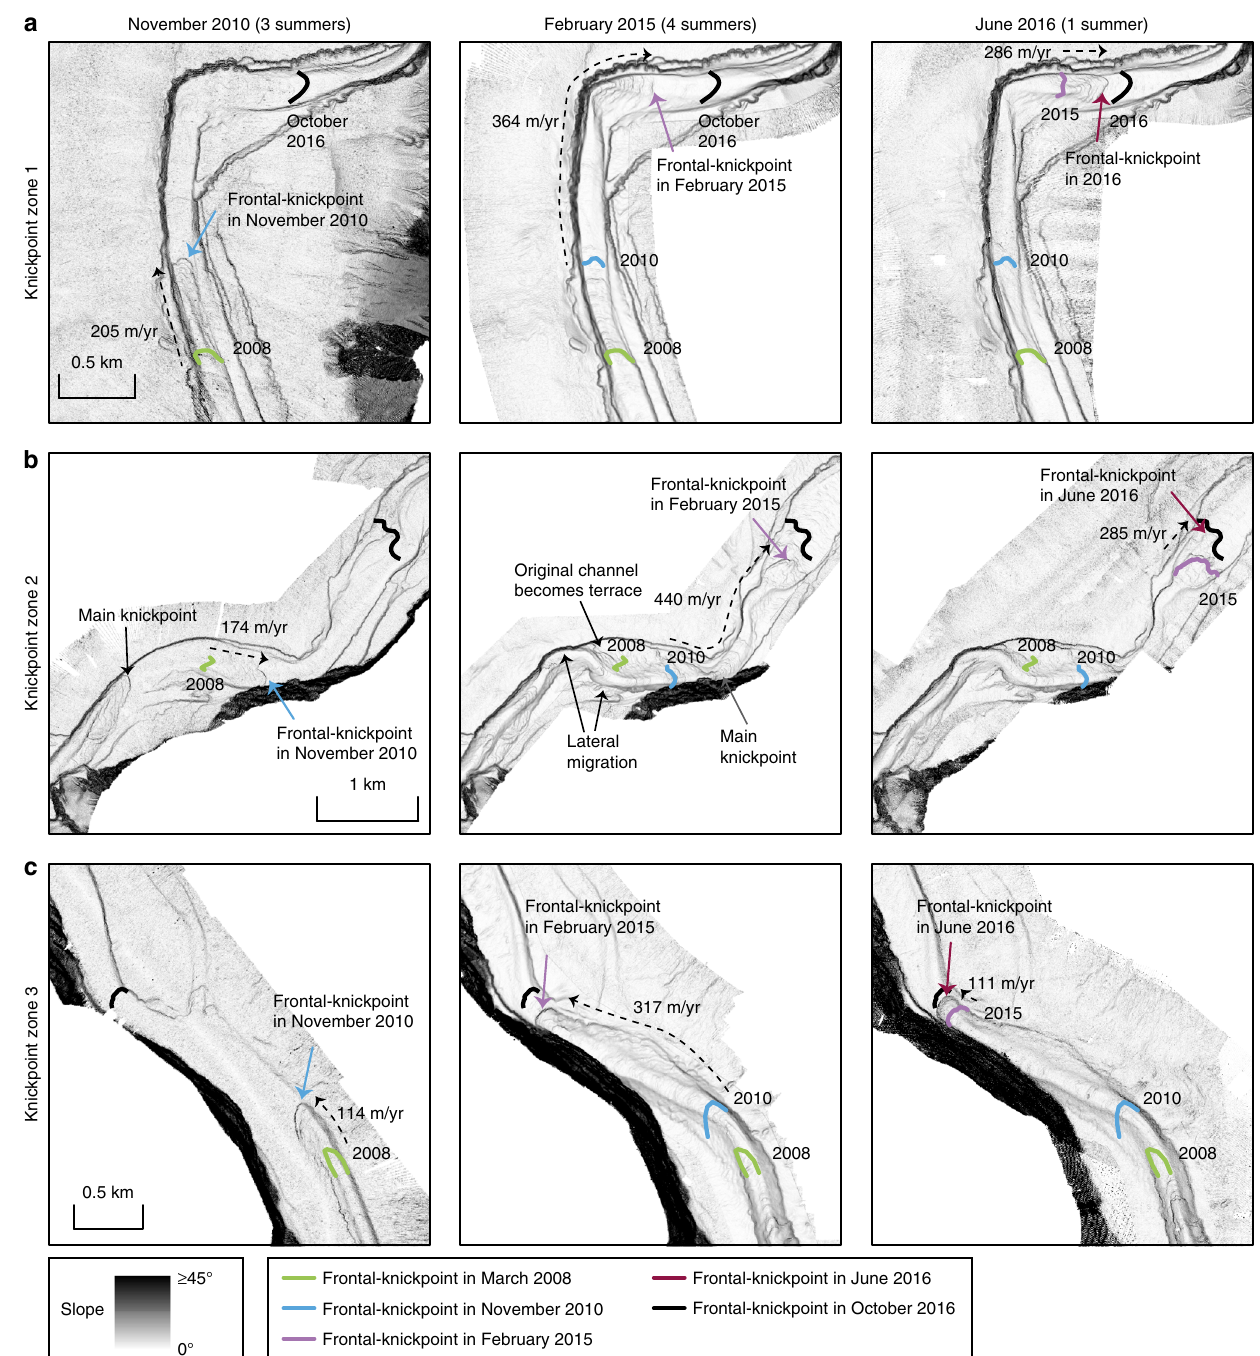
Fig. 6 Detailed time-lapse maps in the three knickpoint zones. Locations shown in Fig. 2a. Time steps from March 2008 and October 2016 are shown in Fig. 5. a Time-lapse evolution of knickpoint-zone 1. b Time-lapse evolution of knickpoint-zone 2. Knickpoints migrate outside of the original channel, causing lateral migration of the channel in some parts. The original channel fl oor locally becomes a terrace. The resulting channel is narrower and more sinuous. c Time lapse evolution of knickpoint-zone 3. Knickpoint migration creates a channel where previously no well-developed channel